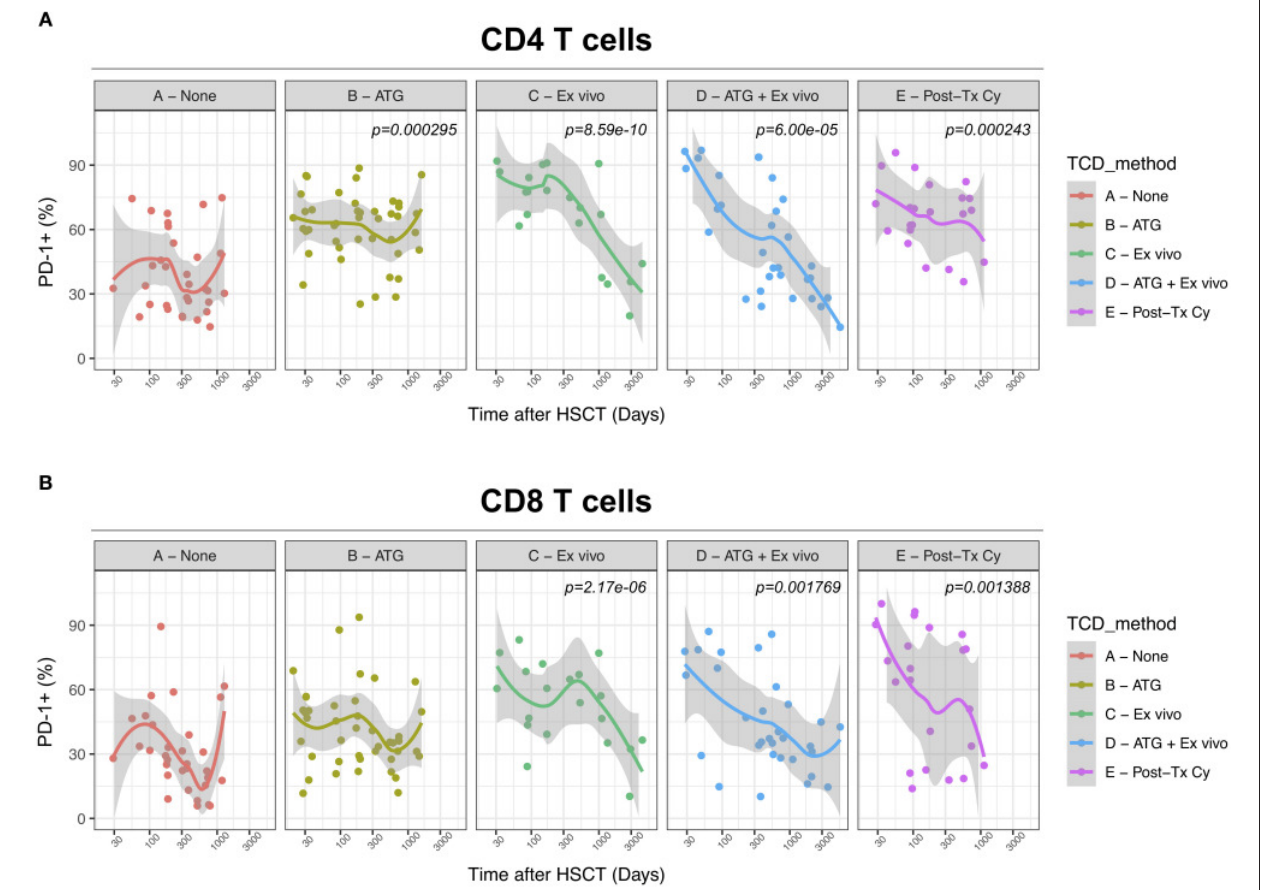
FIGURE 7 | Impact of different methods of T-cell depletion on PD-1 expression on CD4 and CD8T cells after allogeneic HSCT. Comparison of PD-1 expression on CD4 (A) and CD8 (B) T cells from HSCT recipients receiving the indicated type of T-cell depletion. The p -values resulting from the multivariable linear regression analysis are indicated when